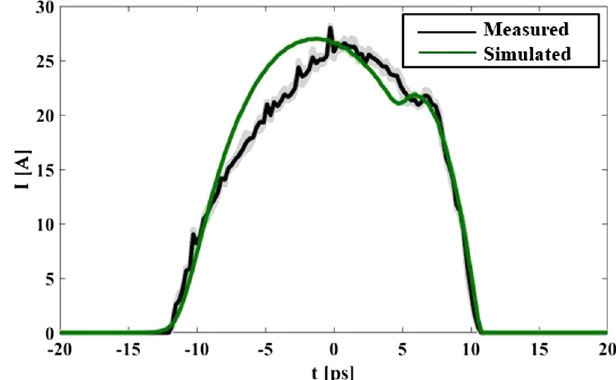
FIG. 19. Comparison of the bunch profile between measure- ment and simulation at 550 pC. The shading curves show 5 individual measurements and the solid black curve shows the average. The green curve represents the simulation result.